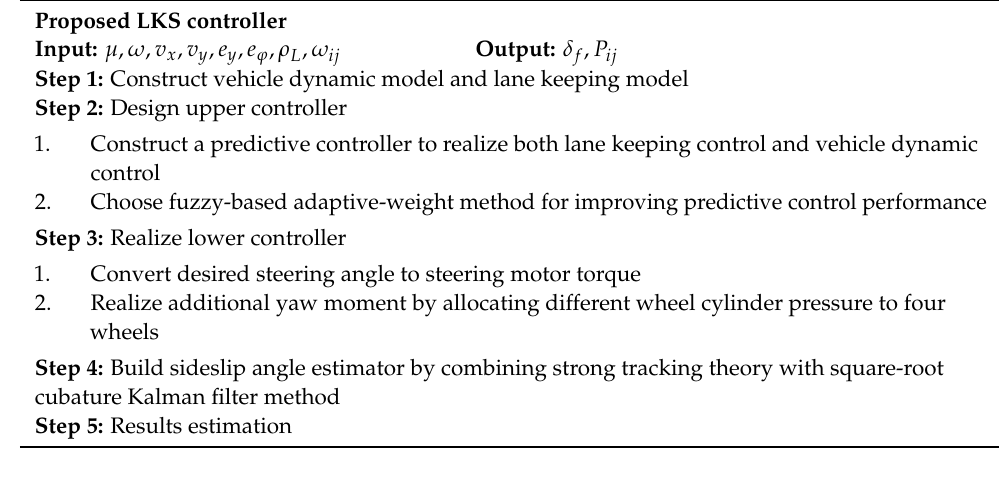
Algorithm 1: The brief processing of proposed LKS controller